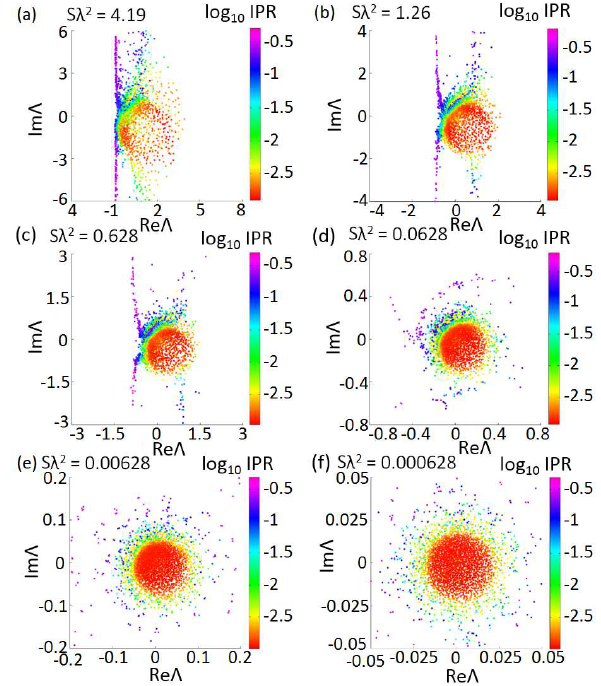
Figure 9. Eigenvalue distributions of the dyadic Green’s matrix in the complex plane for N = 1000 random array with ( a ) S λ 2 = 4.19; ( b ) S λ 2 = 1.26; ( c ) S λ 2 = 0.628; ( d ) S λ 2 = 0.0628; ( e ) S λ 2 = 0.00628; ( f ) S λ 2 = 0.000628. The color bar shows the inverse participation ratio (IPR) of the eigenmode associated to each eigenvalue in log scale. The insets in ( a – d ) highlight the central part of the eigenvalue